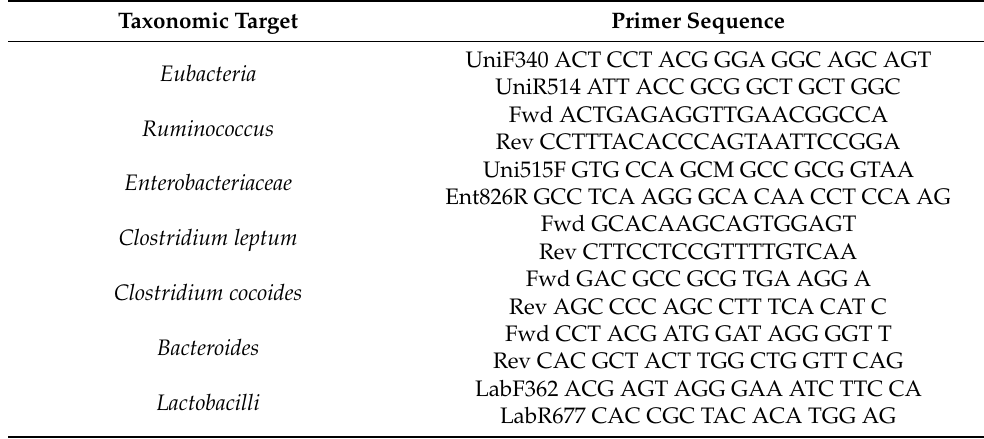
Table 1. Primers used in this study (Hayashi,